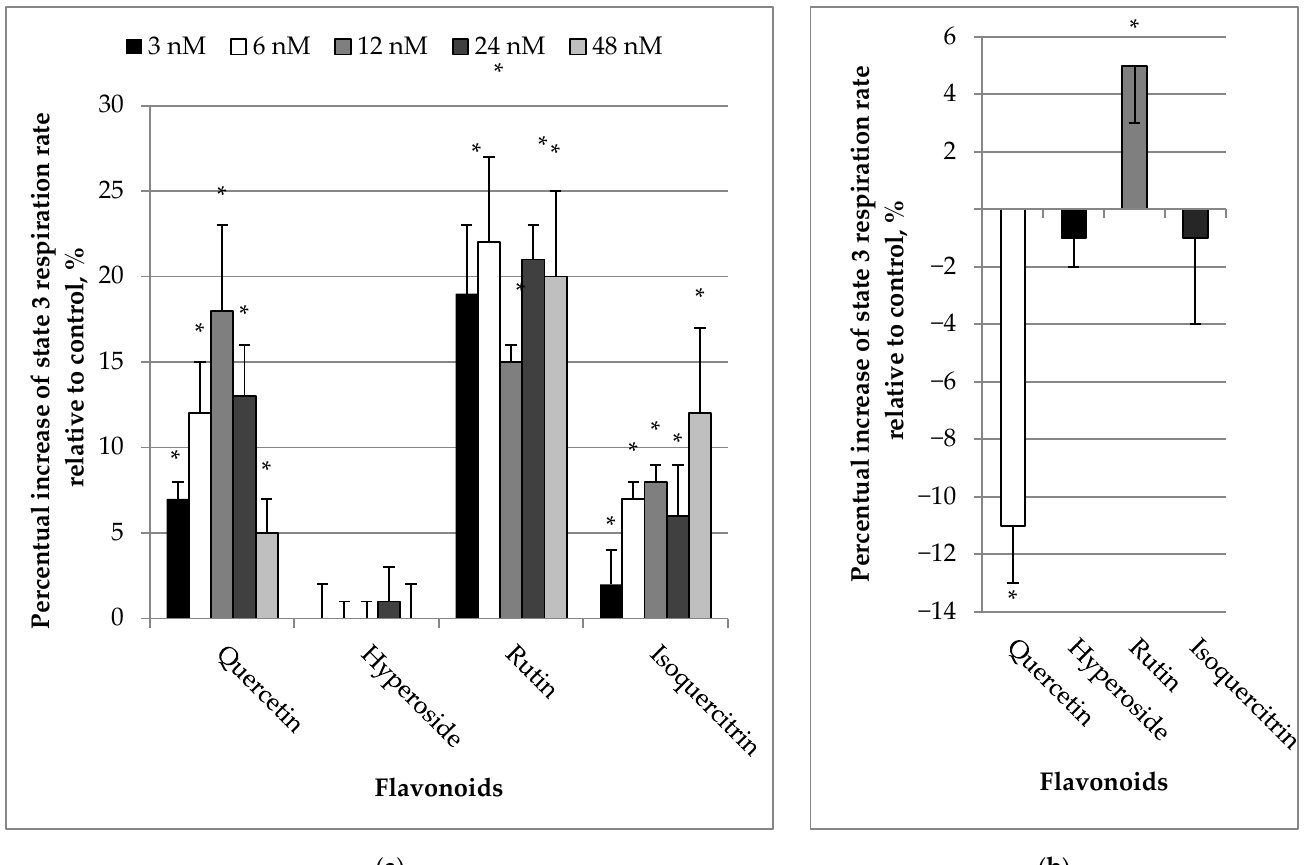
Figure 3. ( a ) Effect of flavonoids (3–48 nM) on State 3 respiration rates in kidney mitochondria. ( b ) Effect of flavonoids (10 µM) on State 3 respiration rate in kidney mitochondria. The mitochondrial Sstate 3 respiration rate was recorded in a medium supplemented with mitochondria, substrates (5 mM glutamate + 5 mM malate and 1 mM ADP) as described in Materials and Methods. The respiration rate of mitochondria without added flavonoids was considered as the control. The effect was calculated according to the Formula (2). * Statistically significant difference ( p < 0.05) compared to control (State 3 respiration rate without flavonoids).